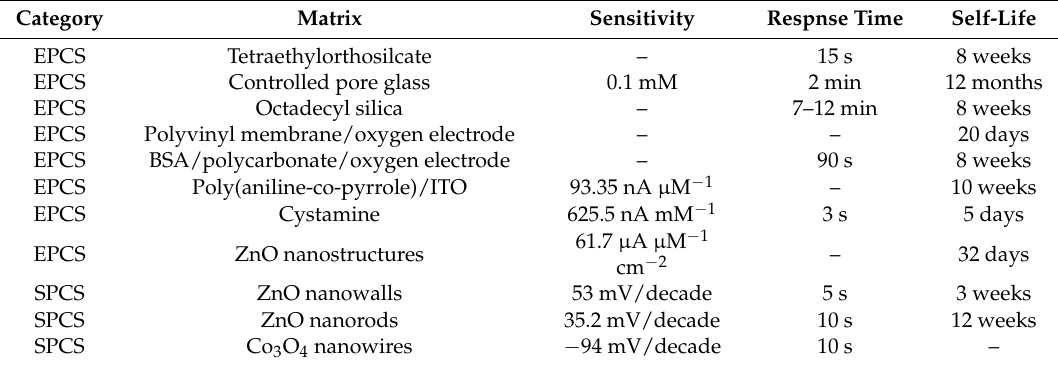
Figure 4. ( a ) Output response for the cholesterol biosensor against the reaction time. ( b ) Storage capability of the biosensor repeatedly tested for 10 consecutive days [25]. Table 2. Categories of externally powered or self-powered chemical sensors [23,25–34].